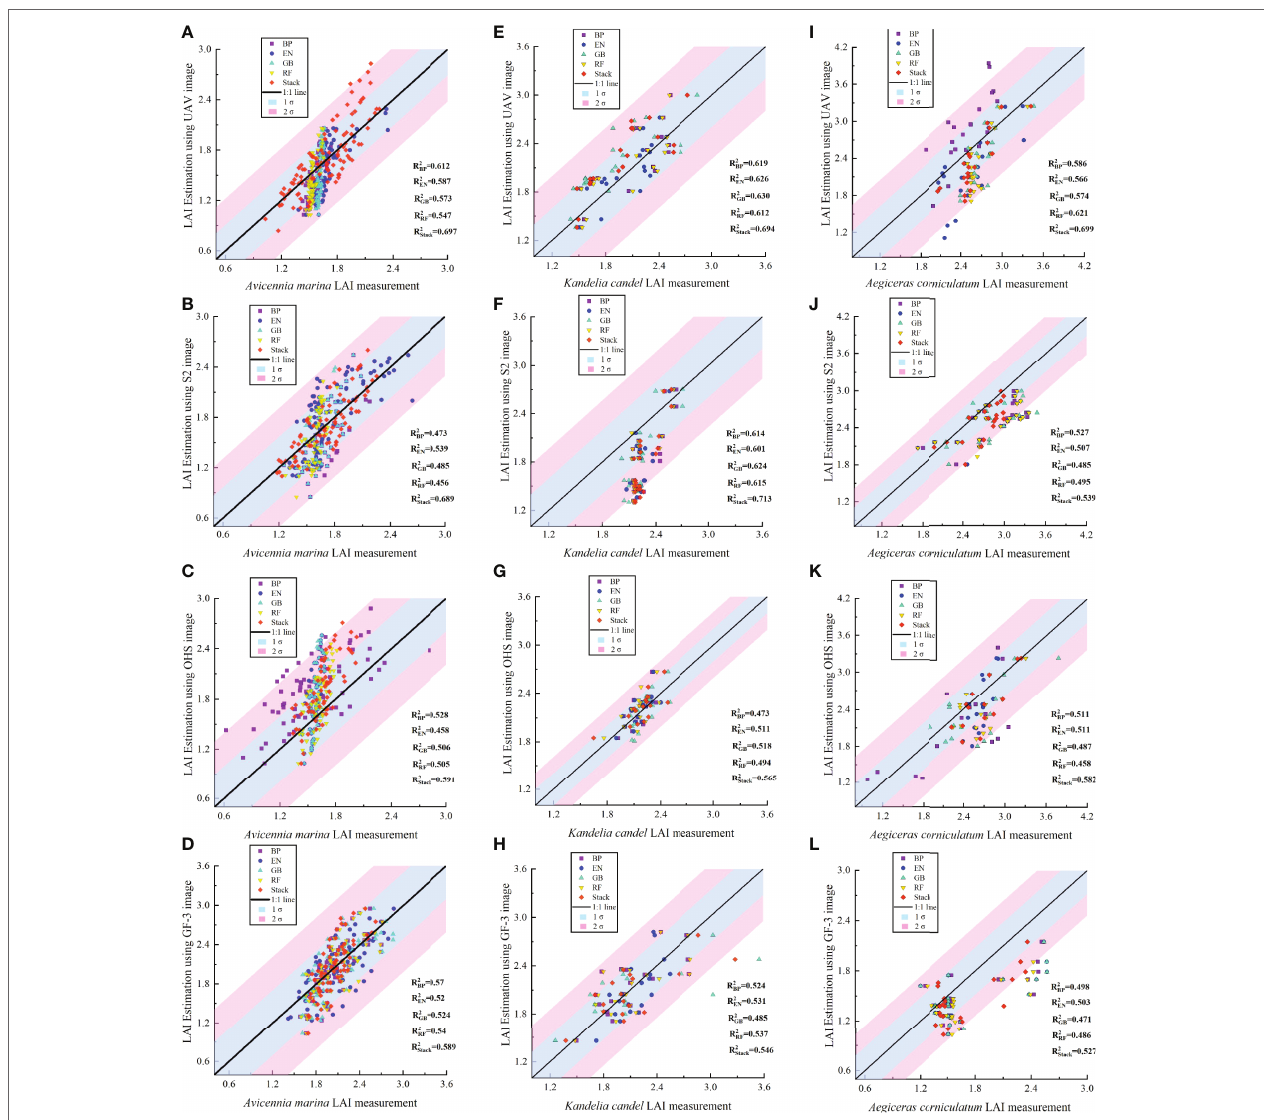
FIGURE 6 | Statistical analysis of the LAI estimation accuracy of different mangrove communities using the ELR model. The shaded area represents the standard deviation ( σ ) between the estimated and measured LAI value of mangrove communities. (A–L) Respectively represent the LAI estimation accuracy (R2) of 'Avicennia